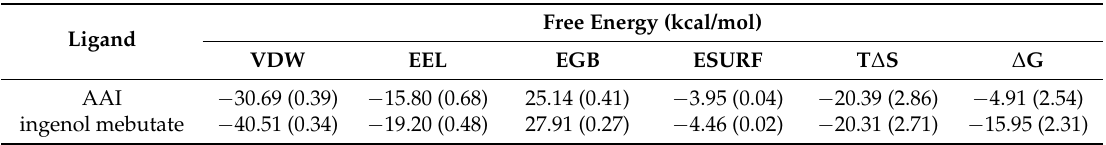
Table 1. Decomposition of free energy of AAI and ingenol mebutate to PKC δ Cys2 domain. Ligand